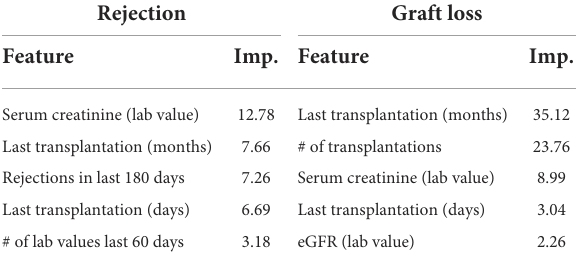
TABLE 1 Overview of the most relevant features (top 5) of each model (global features), including its importance